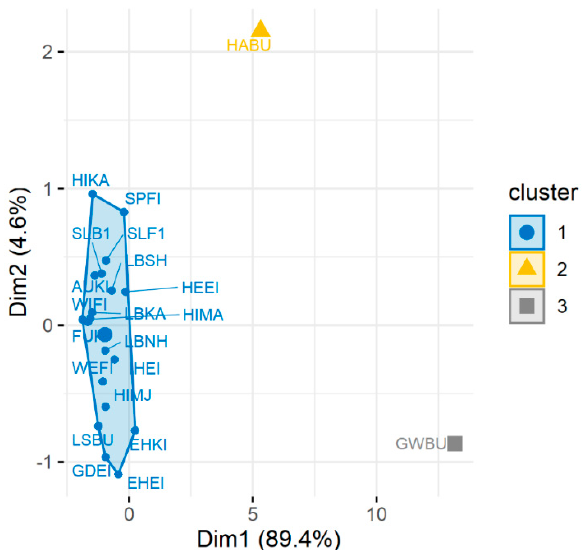
Figure 8. First two components of a principal component analysis of soil chemical variables at the most recent (Figure 3) soil inventory and designation of permanent soil monitoring plots to clusters 1 to 3. Clusters 2 and 3 consist of only one plot each. Abbreviations show the last four letters of the plot code (see Table 1).